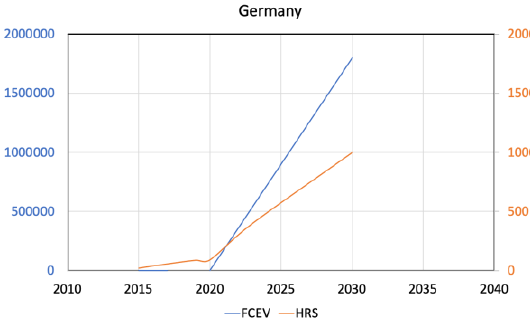
Fig. 4. The number of HRS and FCEVs in Germany (2015–2030) The